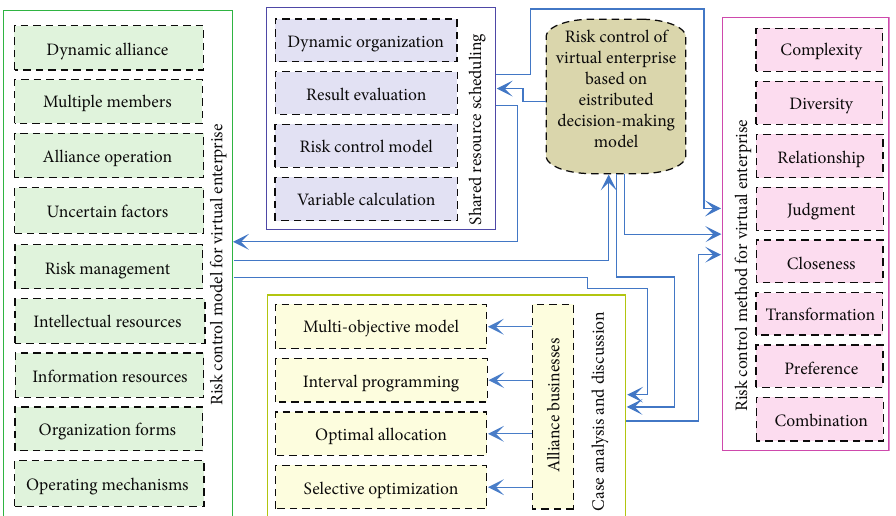
Figure 1: Analytical framework of risk control for virtual enterprise based on distributed decision-making model.